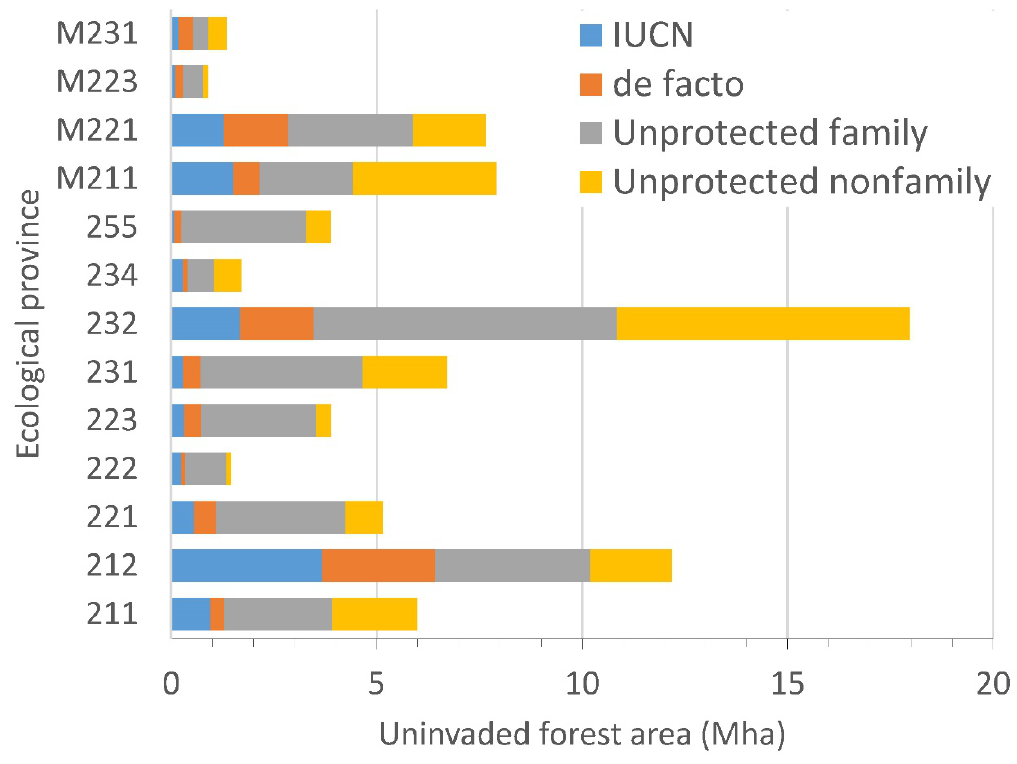
Figure 3. Estimated area of uninvaded forest by ecological province and protection category. IUCN includes all IUCN protection categories and de facto includes both Federal and nonfederal ownerships. Note: “unprotected family” is private, family-owned, no IUCN designation;